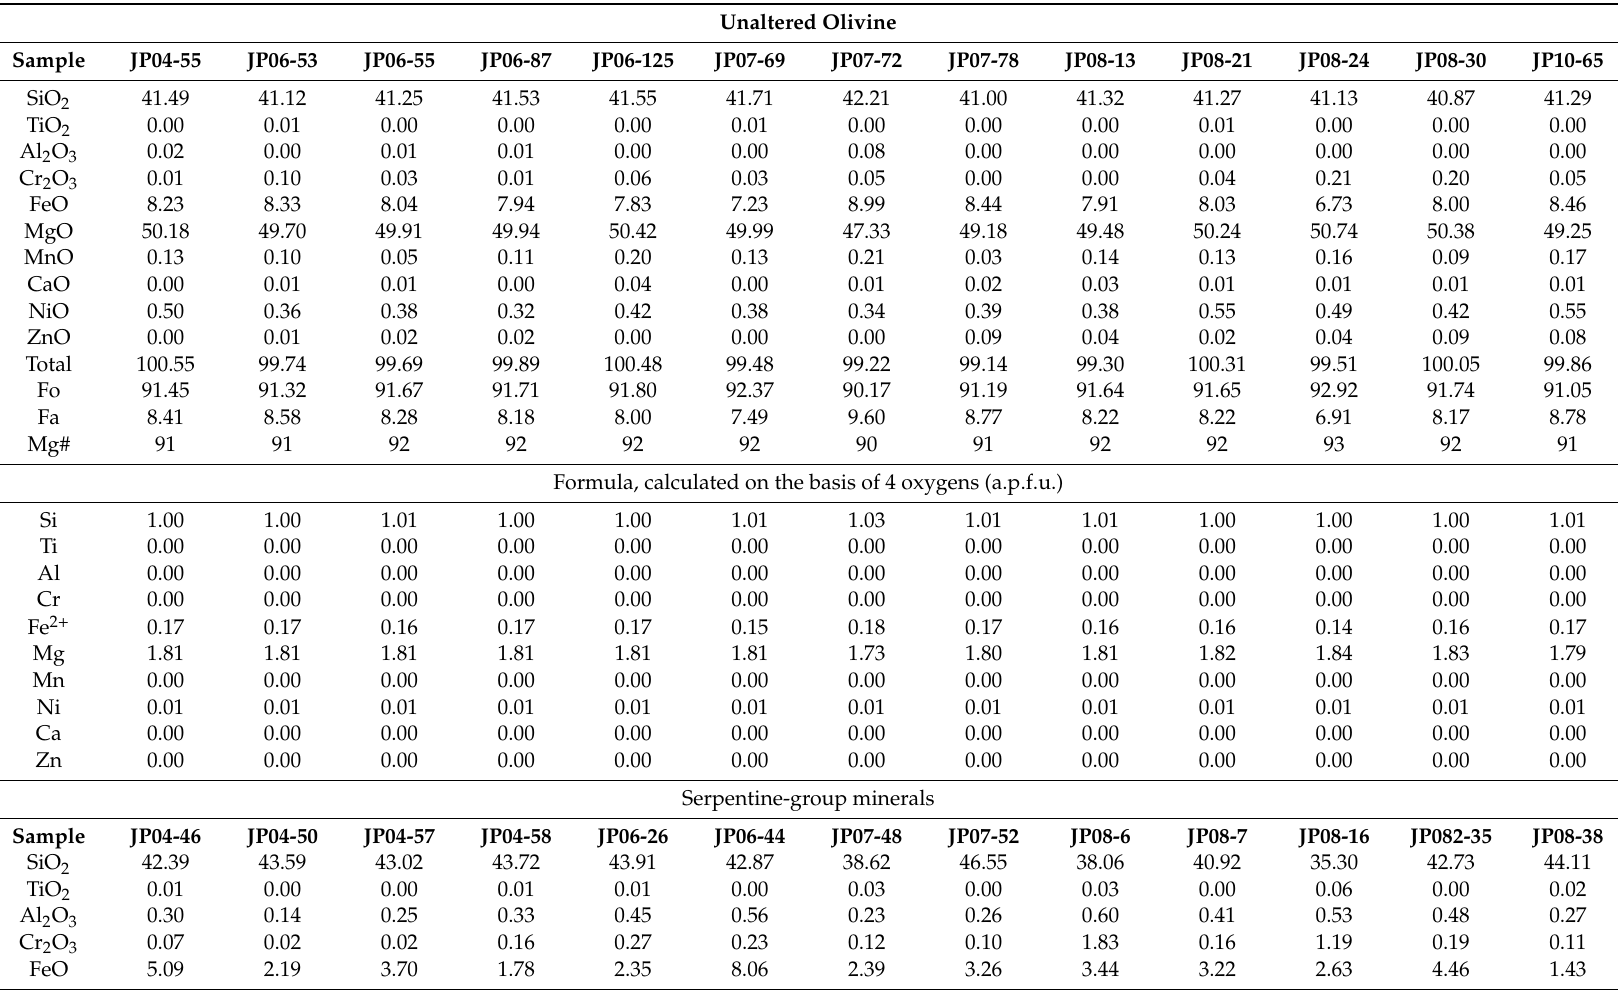
Table 5. Chemical composition of unaltered and altered olivine (in wt%) from EPMA